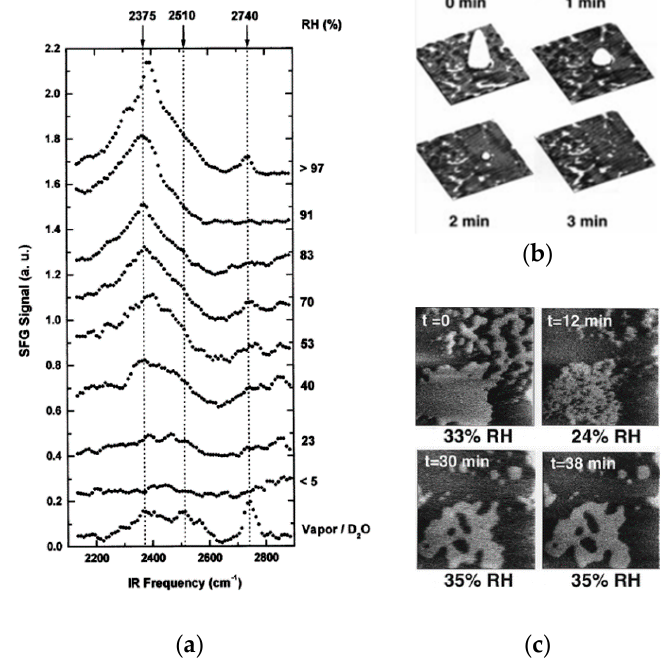
Figure 7. ( a ) Sum frequency generation (SFG) spectra of a water (D 2 O) film on a mica surface as a function of RH at room temperature (296 K); The spectrum of the bulk waver/vapor interface is added as a comparison (the bottom trace). ( b ) SPFM images (6 μ m × 6 μ m) showing the evaporation of a droplet of water left on the mica surface after breaking the capillary neck formed around the atomic force microscopy (AFM) tip during contact. ( c ) SPFM images (3.4 μ m × 3.4 μ m) showing the size of the water islands at different RH. Reprinted from Ref. [63,65], Copyright 1998, with permission from ACS publications & APS publications.